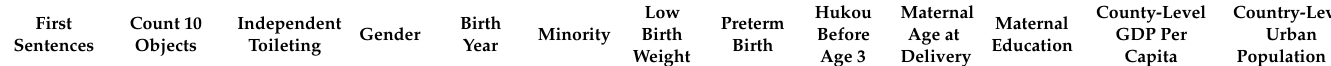
Variables Walking alone